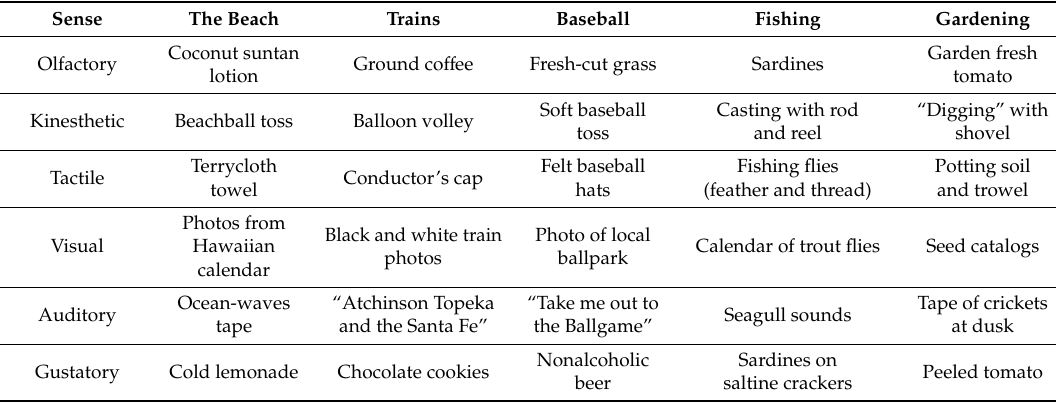
Table 2. Sample of Motor and Multisensory Care sessions (reprinted from Trudeau SA. Bright Eyes: a structured sensory-stimulation intervention. In: Volicer L, Bloom-Charette L, editors. Enhancing